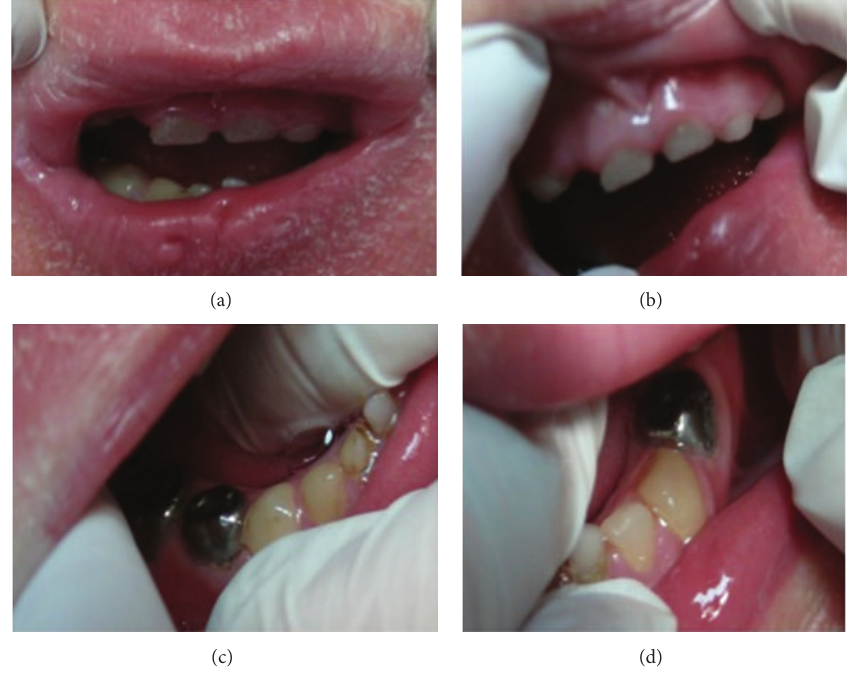
Figure 3: Intraoral view after the dental